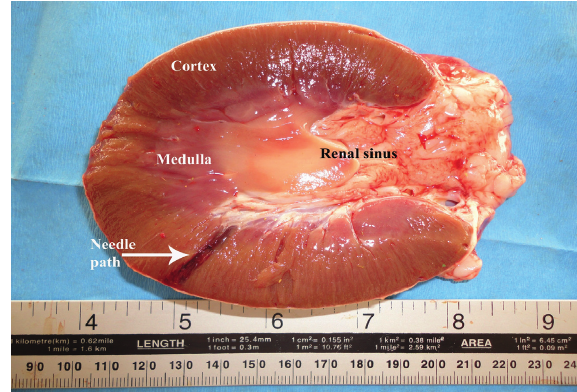
Figure 9: Under ultrasound guidance, renal biopsy needle path is usually easily identified within the renal cortex at post-mortem examination.